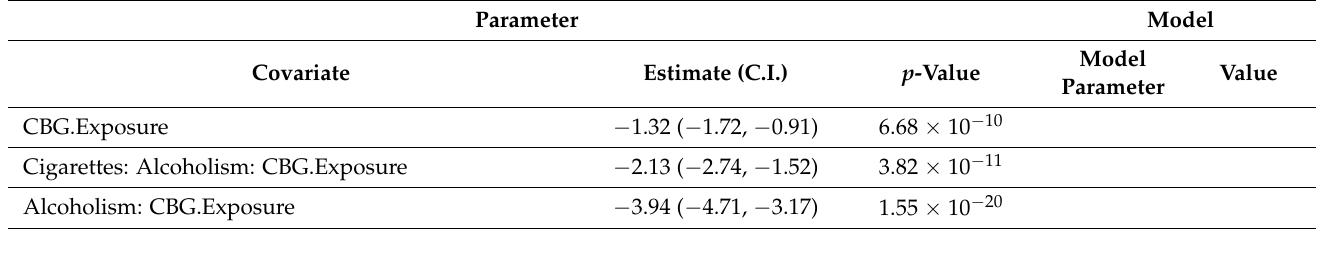
Table 3. Cont. Parameter Model Covariate Estimate (C.I.) p -Value